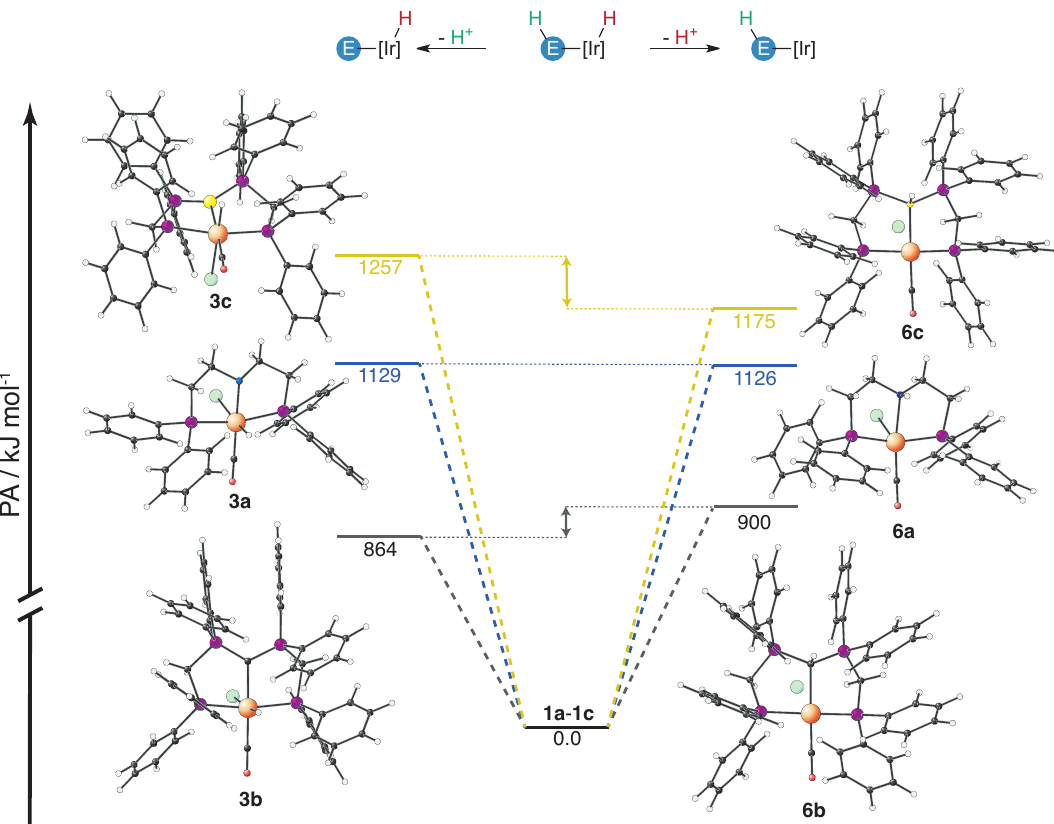
Figure 8. Proton affinities and DFT-optimized structures of 3a – 3c and 6a – 6c (G16,